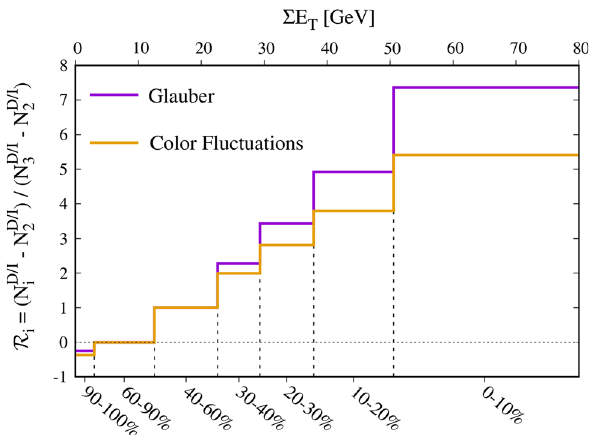
Fig. 7 Centrality dependence of DPS multiplicity enhancement as a (cid:2) E T measured in − 3 . 2 ≥ η ≥ − 4 . 9 (along the nucleus function of direction) which corresponds centrality bins denoted in the